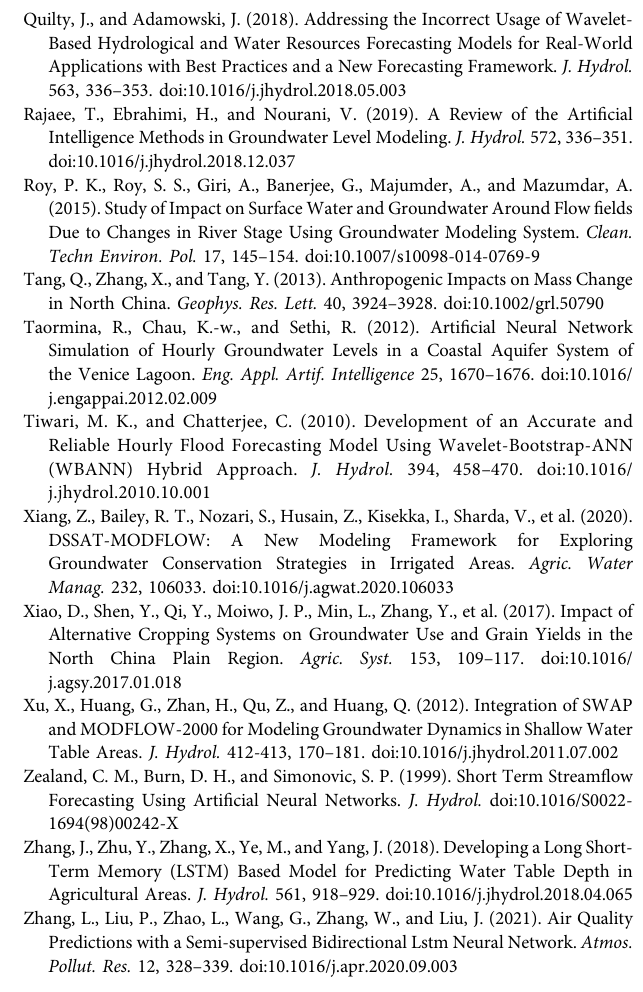
Table Areas. J. Hydrol. 412-413, 170 – 181. doi:10.1016/j.jhydrol.2011.07.002 Zealand, C. M., Burn, D. H., and Simonovic, S. P. (1999). Short Term Stream fl